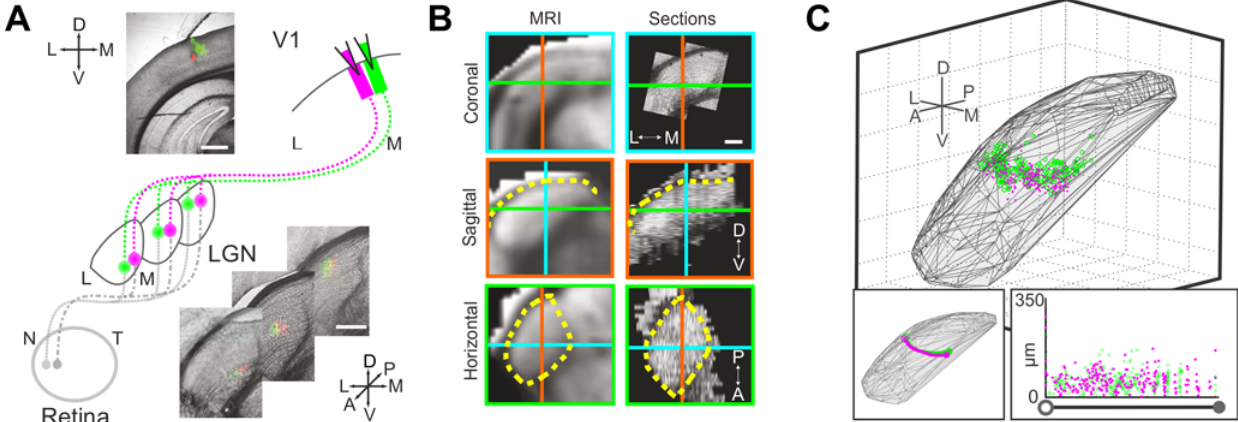
Fig 1. Three dimensional reconstruction of dLGN-to-V1 projection columns. (A) Fluorescent RetroBeads were injected into V1 and transported into thalamo-cortical projection neurons within the dLGN. (B) Bright-field images of sections registered to 3D standardized space (MRI). Cross-hairs are colour- coded for each orthogonal view. Yellow dashed lines outline the boundary of the dLGN. (C) Reconstructed locations of labelled somas within the boundaries of the standardized dLGN space (mesh). Left inset: summarised trajectory of the dLGN projection column that extends from the pial surface ( ⭕ ) to the ventral boundary of the dLGN ( ● ). Right inset: spread of cells along normalised columns (based on boundary positions: ⭕ - > ● ). Scale bars are 250 μ m.